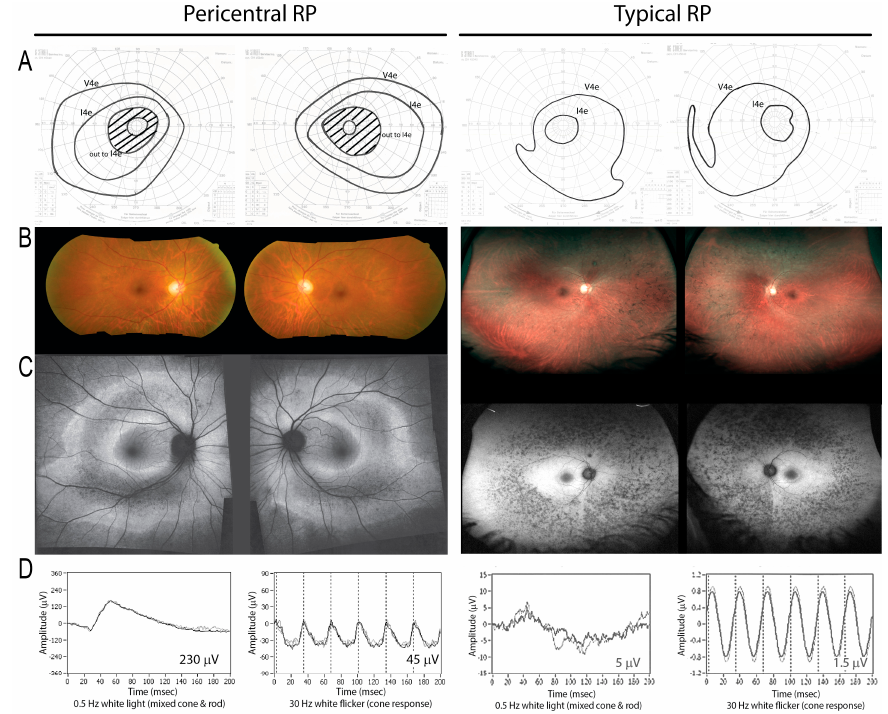
Figure 1. On the left, a patient (Family #14) with a heterozygous RHO mutation demonstrates a pericentral phenotype, with pericentral scotomas but preserved peripheral field to the I4e stimulus on visual field testing ( A ). There is retinal pigment epitheium (RPE) atrophy in the near periphery as shown by fundus photo ( B ) and autofluorescence imaging ( C ), as well as relatively preserved electroretinograms (ERGs) ( D ). In contrast, in typical retinitis pigmentosa (RP) (right), the peripheral response to I4e is lost ( A ), and the affected area is located farther away from the macula in the mid-periphery (right, B , C ; note lower magnification). The ERG is more severely affected ( D ; note different scales; see numerical values, inset).